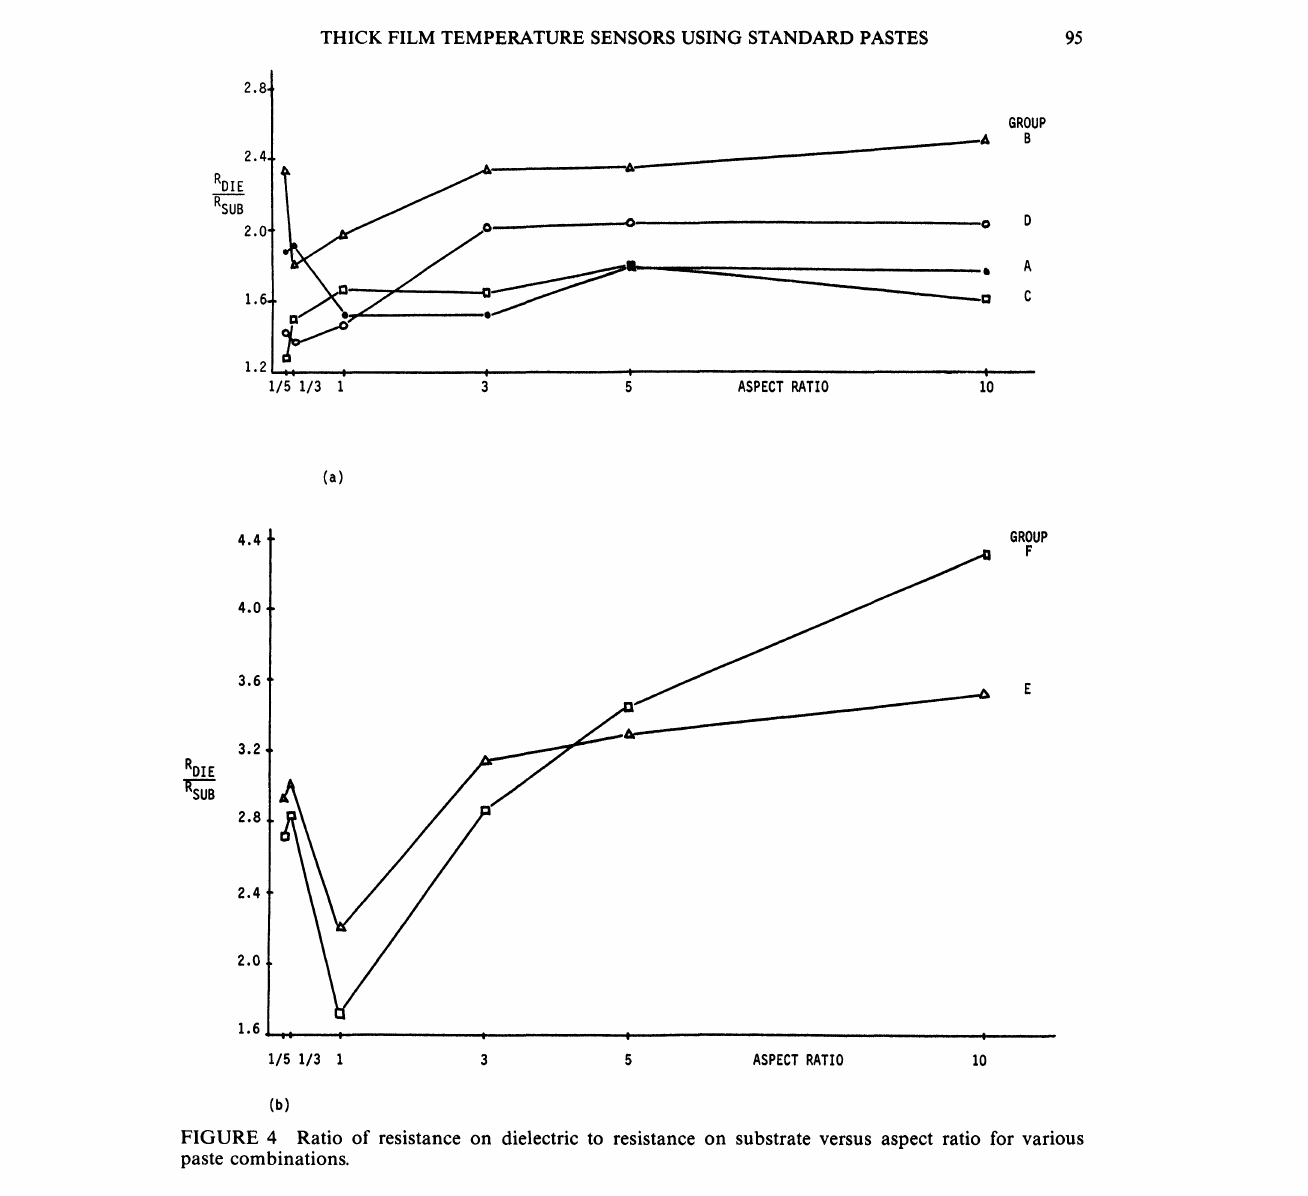
FIGURE 4 Ratio of resistance on dielectric to resistance on substrate versus aspect ratio for various paste